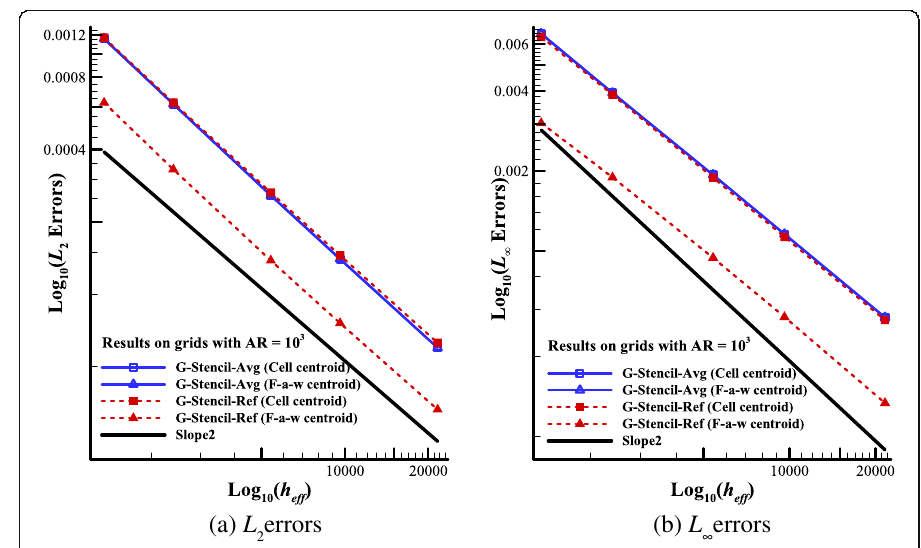
Fig. 16 ( a ) L 2 and ( b ) L ∞ errors. Cell-averaged and point-valued discretization errors of G-Stencil with the geometric centroid and face-area-weighted centroid on grids with AR = 10 3